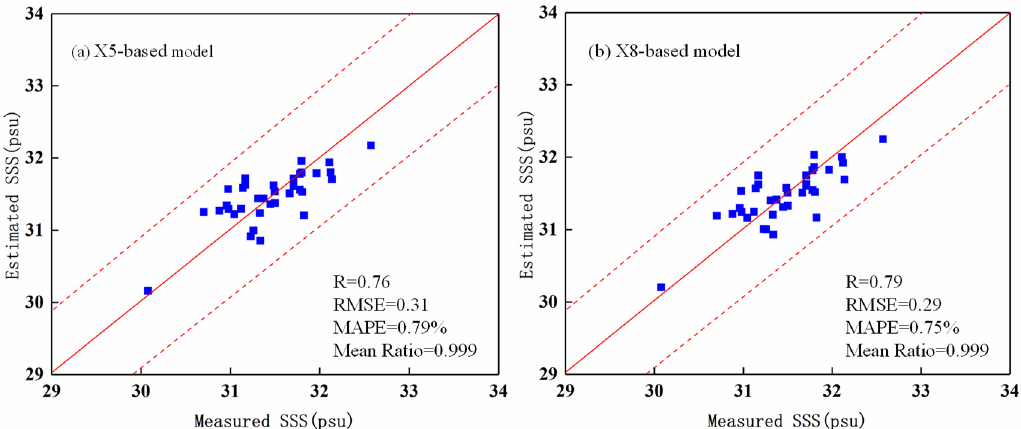
Figure 5. Scatter plots of the in situ measured SSS versus the estimated SSS by using ( a ) the X5-based model and ( b ) the X8-based model. Note that both R values are significant with p <